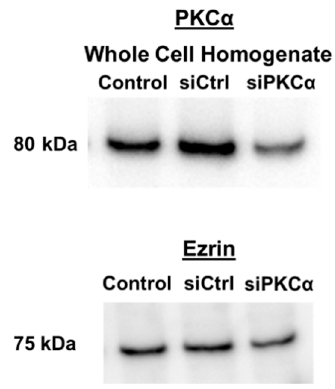
Figure A5. Inhibition of PKC α in IEC-18 cells. Transfection with PKC α siRNA (siPKC α ) led to a